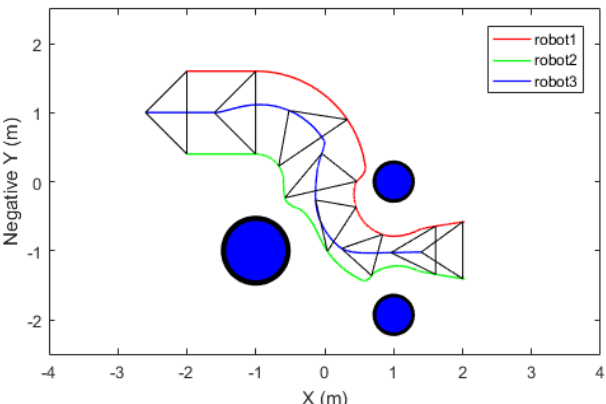
Figure 13. The formation tracking performance for robots in formation with C1–P2.